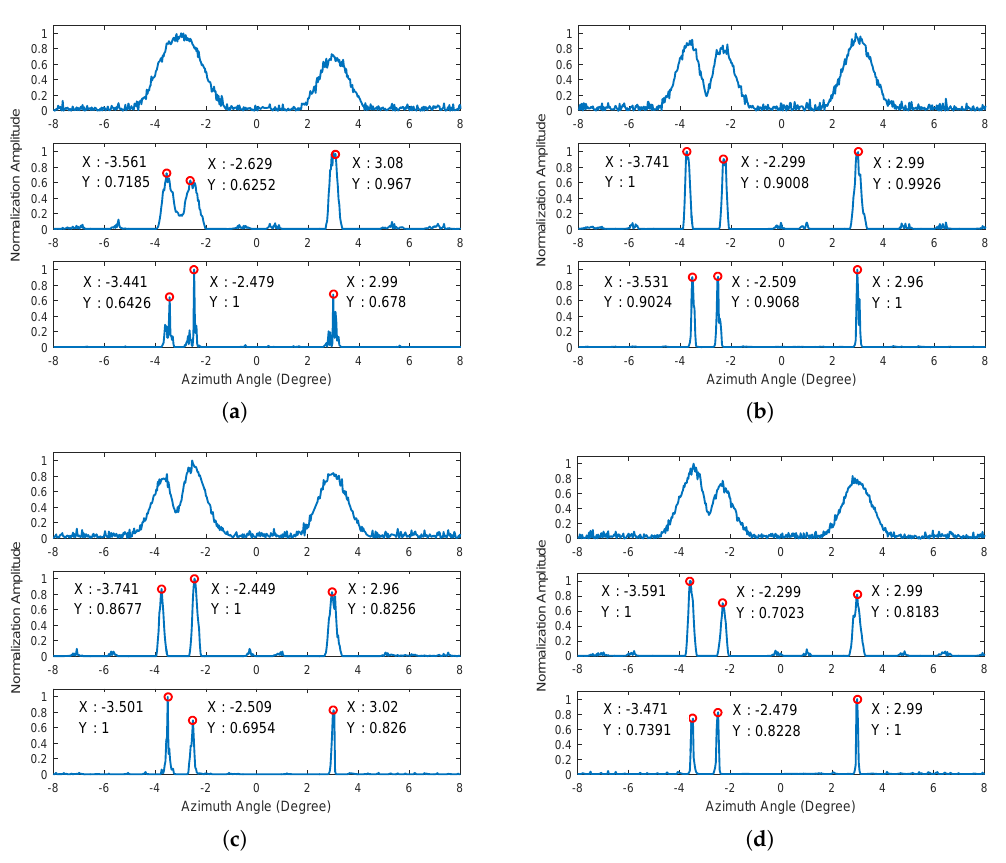
Figure 3. Simulation results of the point target when the SNR is 15 dB. The top subfigure is the cross-range received signal after motion compensation; the middle subfigure is the superresolution result processed by the Poisson-based MAP algorithm; and the bottom subfigure is the result processed by the proposed sparse Bayesian algorithm. ( a ) Platform velocity is 0 m/s; ( b ) platform velocity is 100 m/s; ( c ) platform velocity is 200 m/s; ( d ) platform velocity is 300